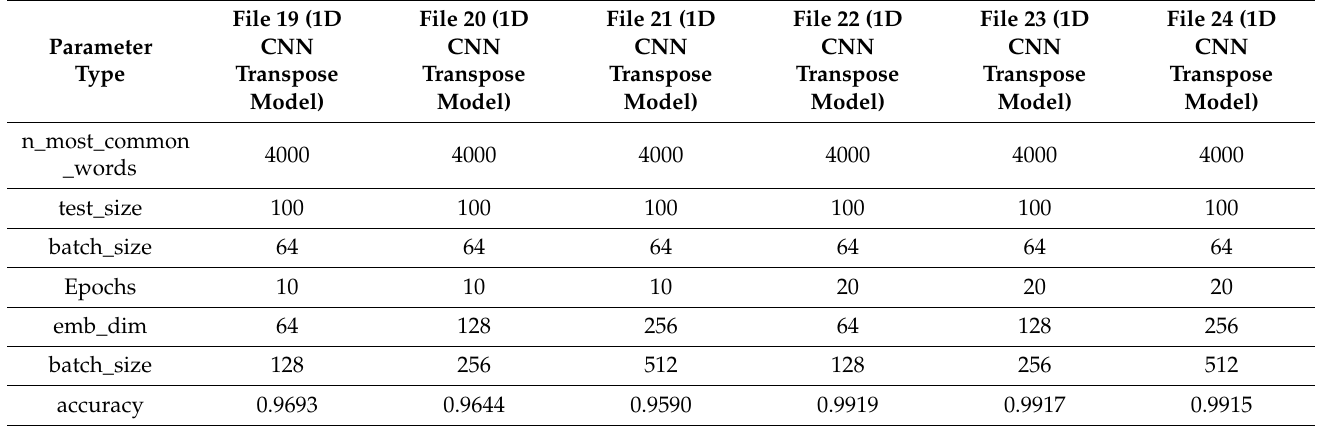
Table 7. Chatbot program test results (Files 19 to 24).